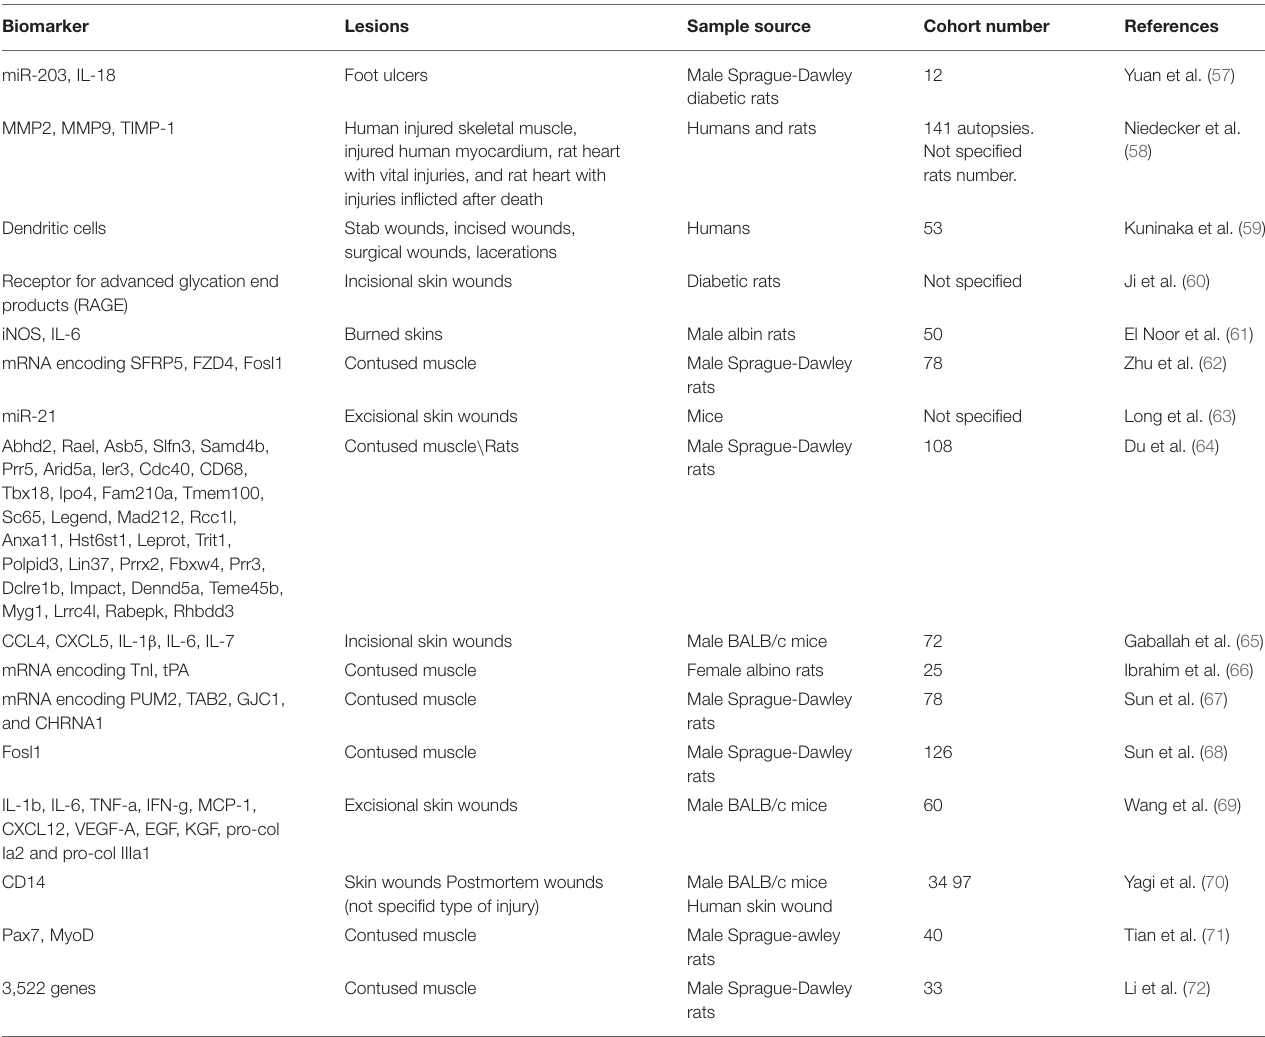
TABLE 1 | Summary of the reviewed